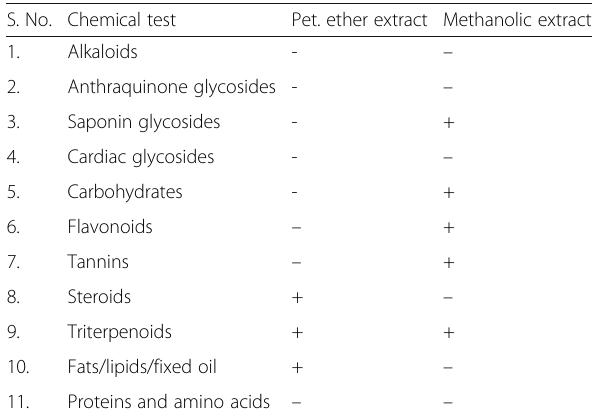
Table 1 Qualitative phytochemical screening of plant